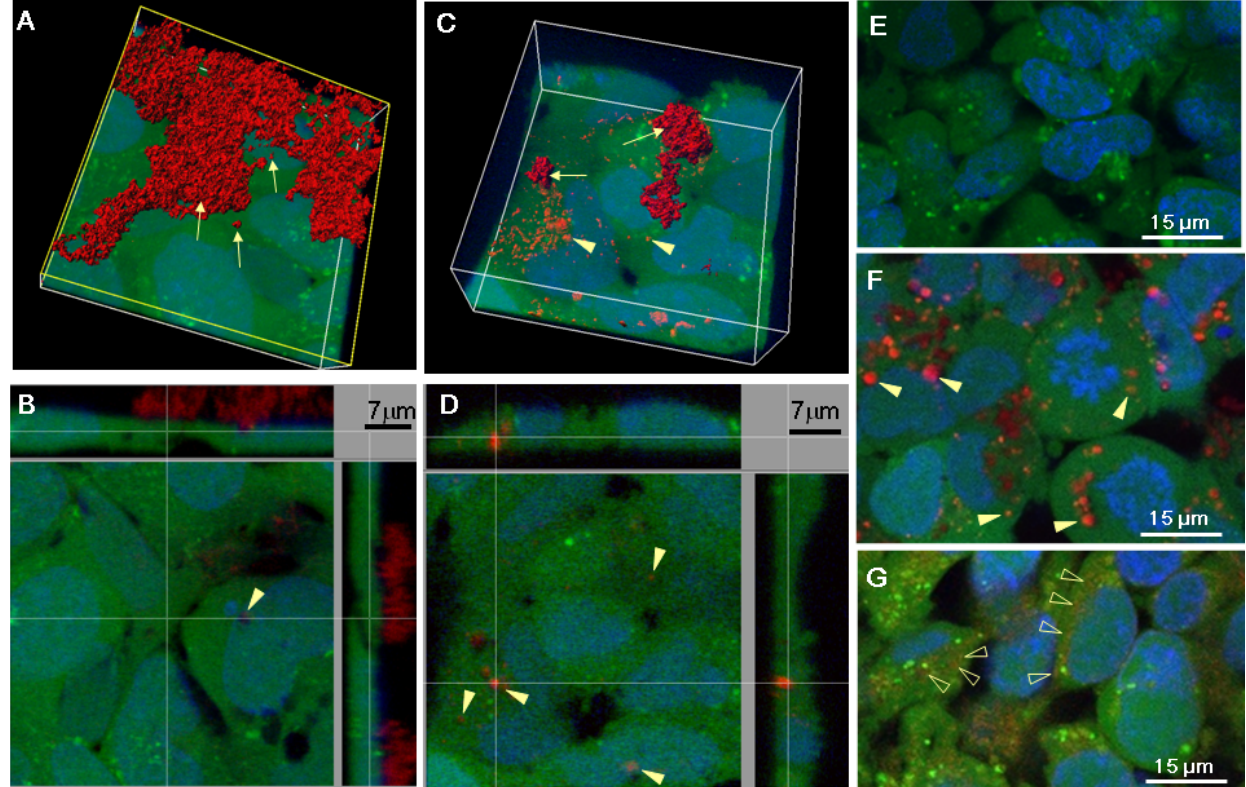
Figure 6. Confocal images of HEK293 cells cultured for 24 h with 80M RITC-chitosan in DMEM pH 7.4 ( A – B ) or DMEM 10% FBS pH 7.4 ( C – D ) (3-D reconstructions). Panels E – G show HEK293 cells in media with 10% FBS ( E ) incubated 24 h with 95M RITC-chitosan ( F ) or rhodamine B ( G ). After chitosan uptake, cells were labeled with calcein AM (green live cell cytosol) and Hoechst 33342 (blue cell nuclei). Arrowheads: intracellular chitosan; arrows: extracellular chitosan. Open arrowheads: rhodamine